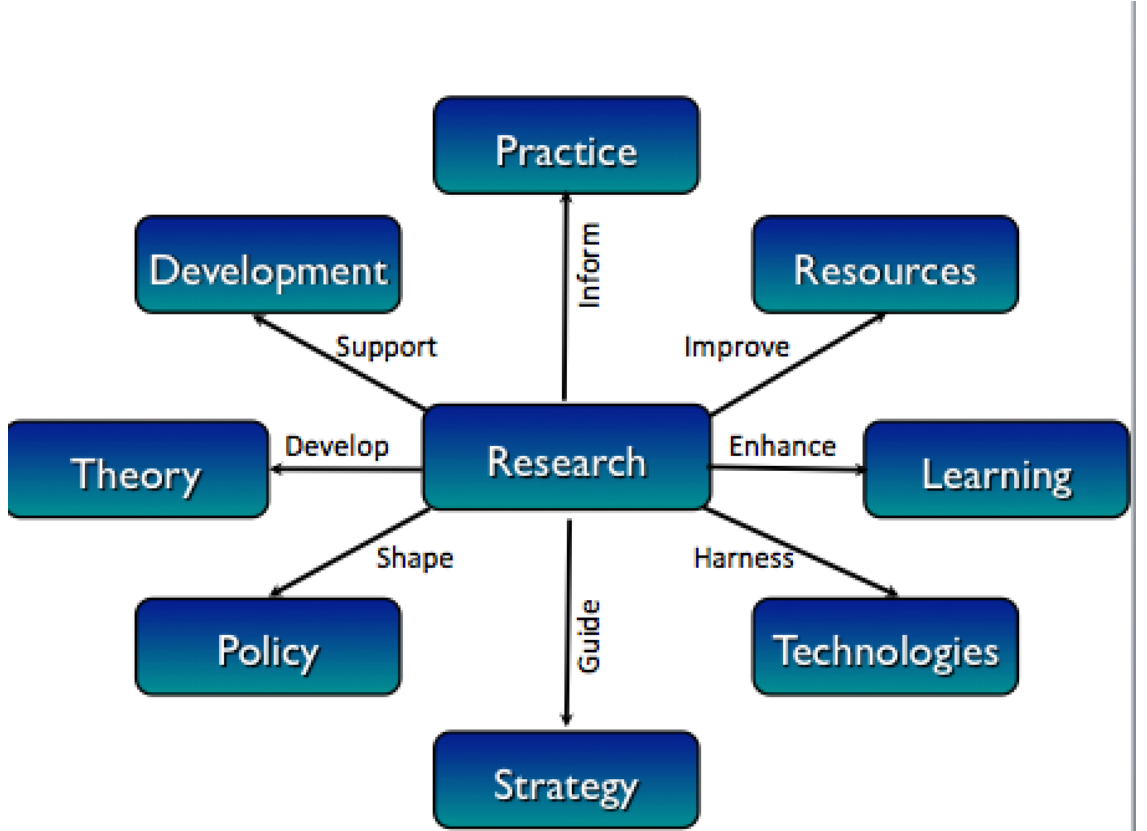
Figure 5: The centrality of digital learning